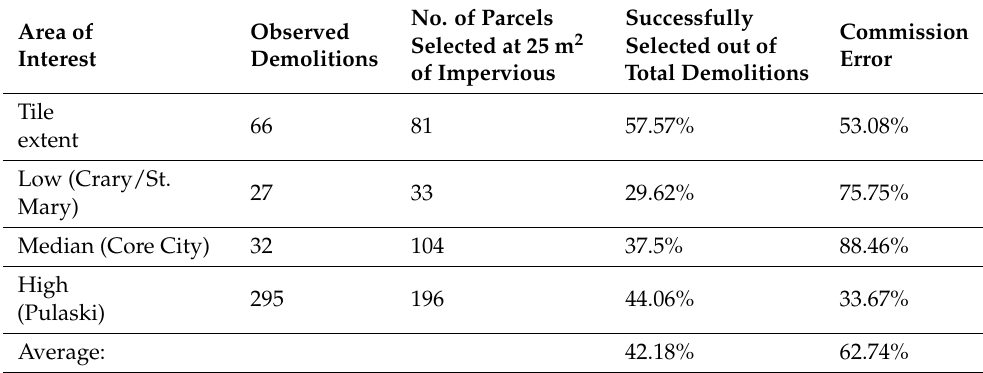
Table 8. Change detection of residential parcel lots based on 25 square metre